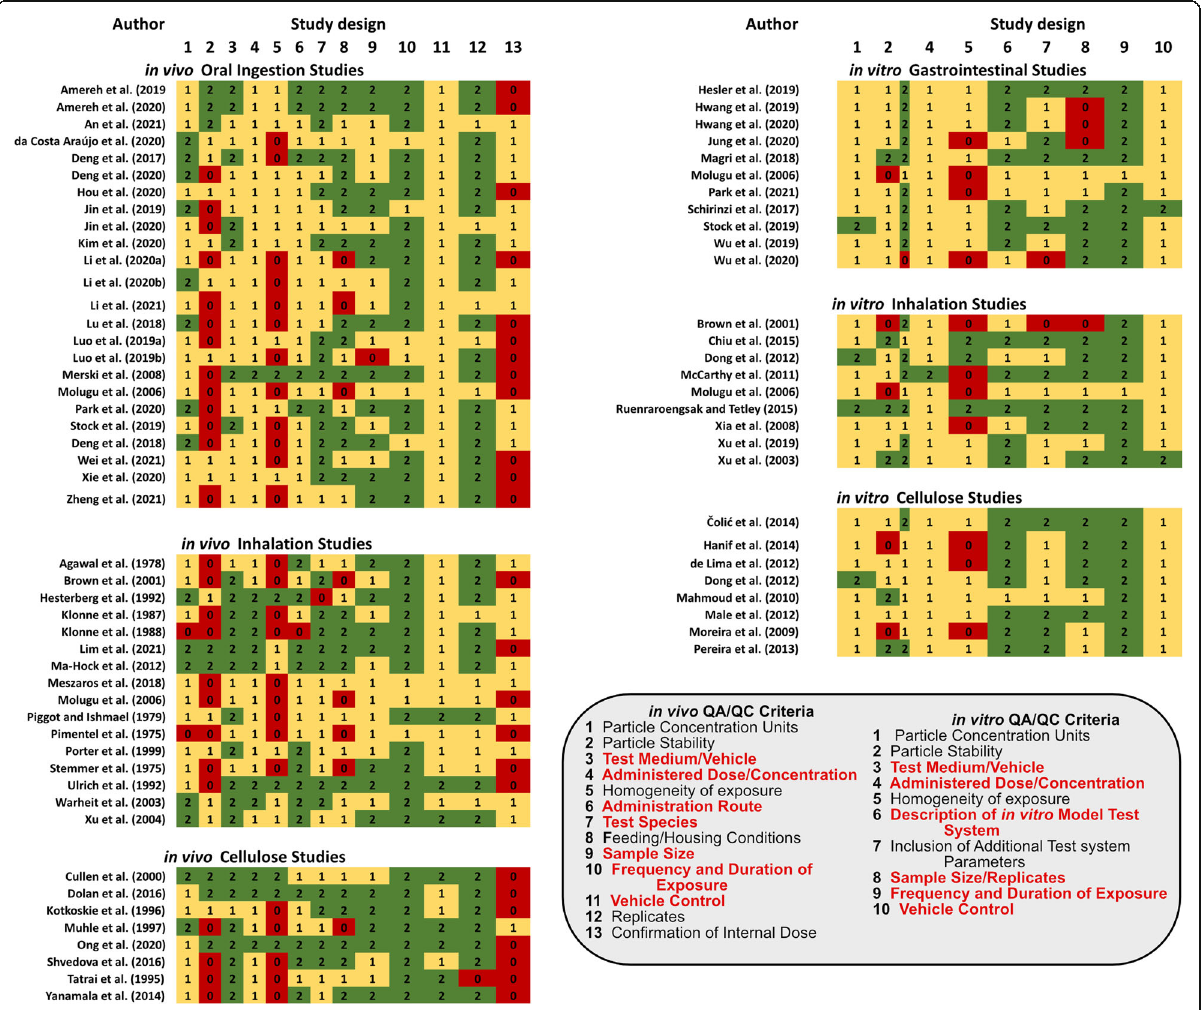
Fig. 3 Summary of evaluation scores for QA/QC criteria aligned with the reporting of study design components of studies assessed by the NMP-TSAT. Please note that some studies report results for both in vitro and in vivo toxicity effects, such as Brown et al. [82], Molugu et al. [72], and Stock et al.